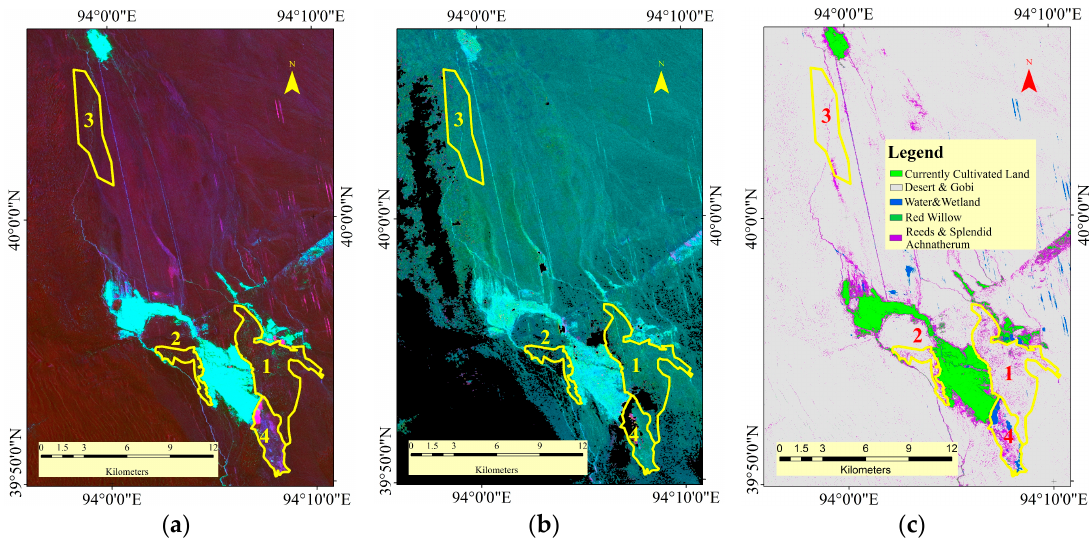
Figure 10. Destroyed dam on the Honggou and a 10-m-wide abandoned road found during the field investigation. ( a ) Field photo of the destroyed dam across the dried-up watercourses; ( b ) field photo of the abandoned road discovered near the dried-up watercourses.